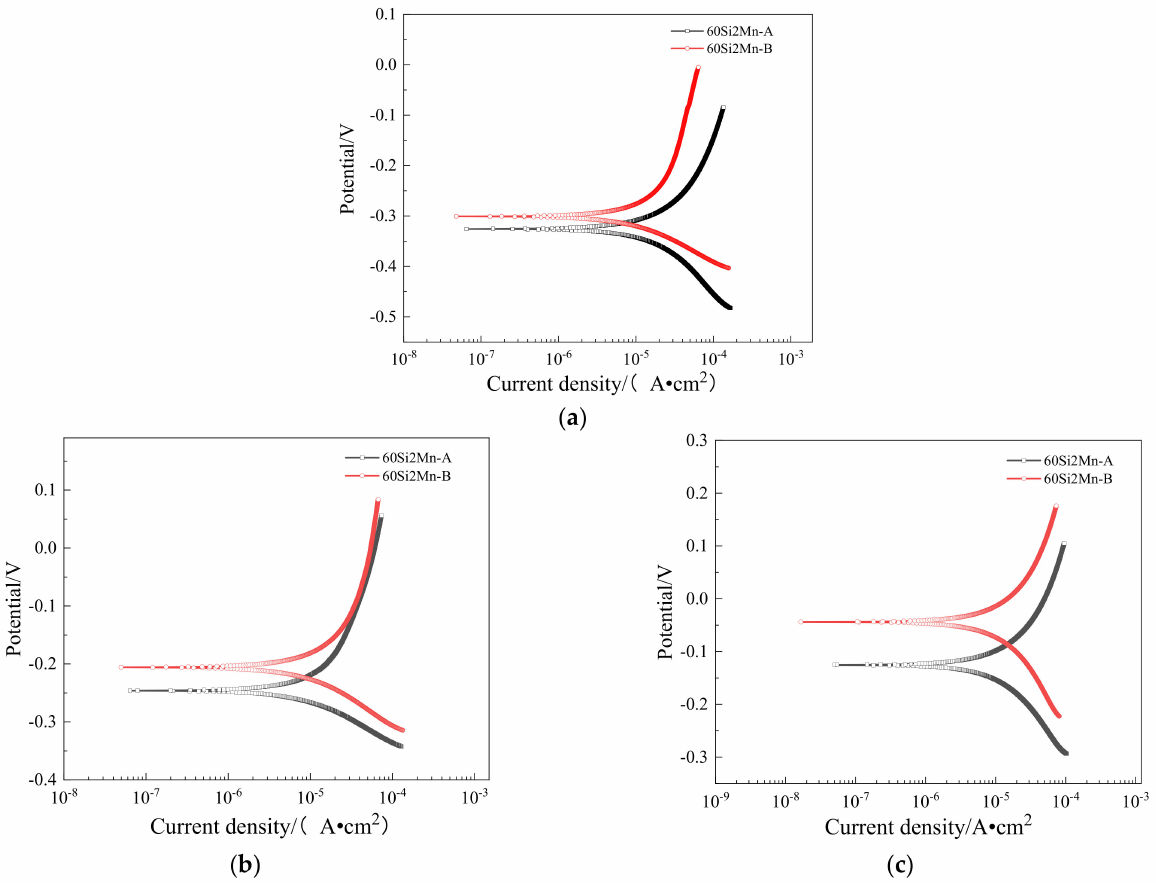
Figure 7. Polarization curves of experimental steels with different corrosion cycles: ( a ) 24 h, ( b ) 72 h, and ( c ) 360 h.